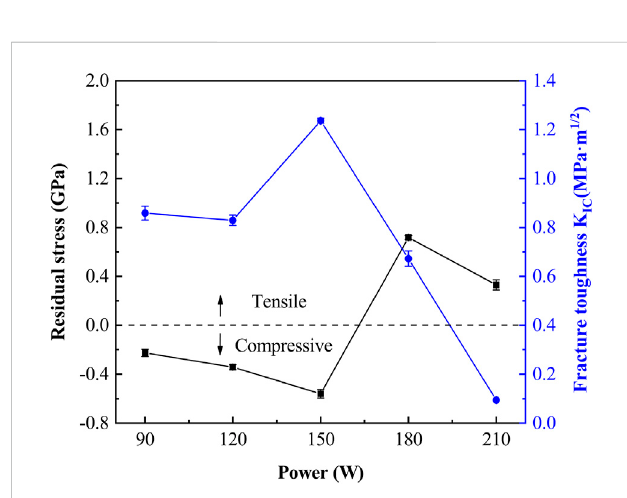
FIGURE 6 Residual stress and fracturetoughness of theZrNbTiMo RHEA fi lms deposited at different sputtering